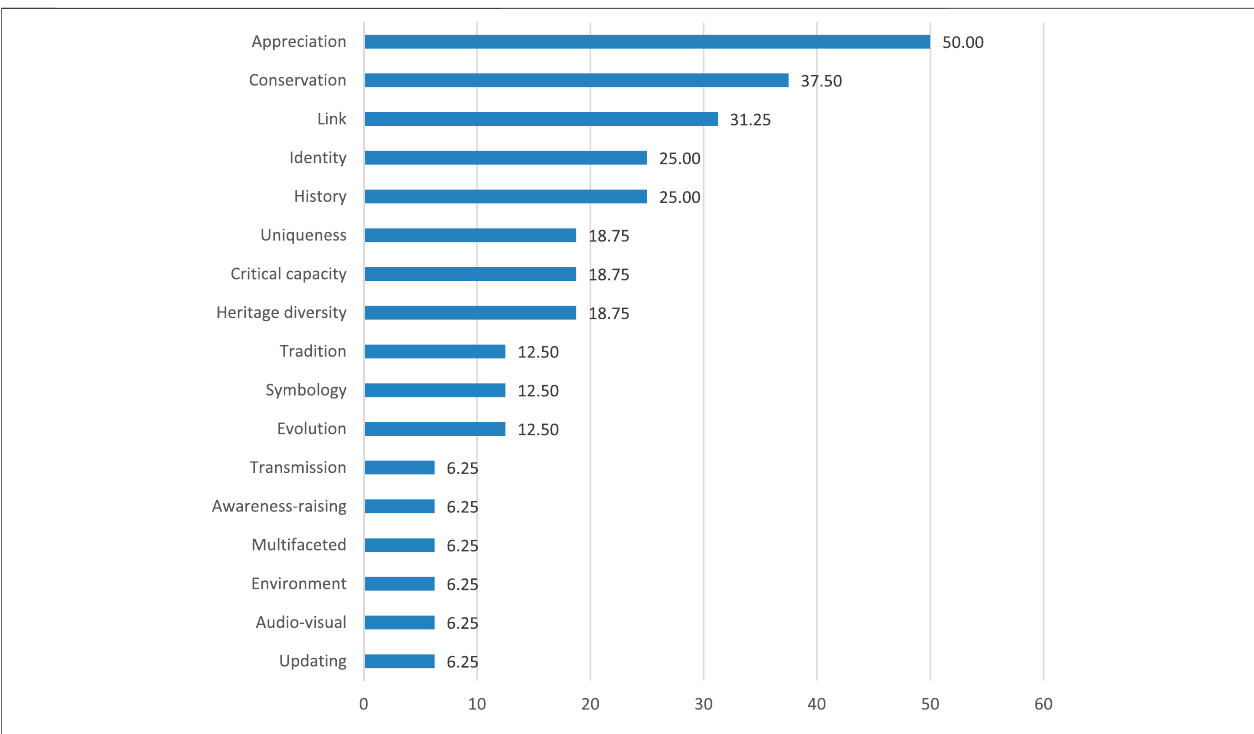
FIGURE 9 | Aspects related with the Way of St. James which the participants would like to transmit in primary education.